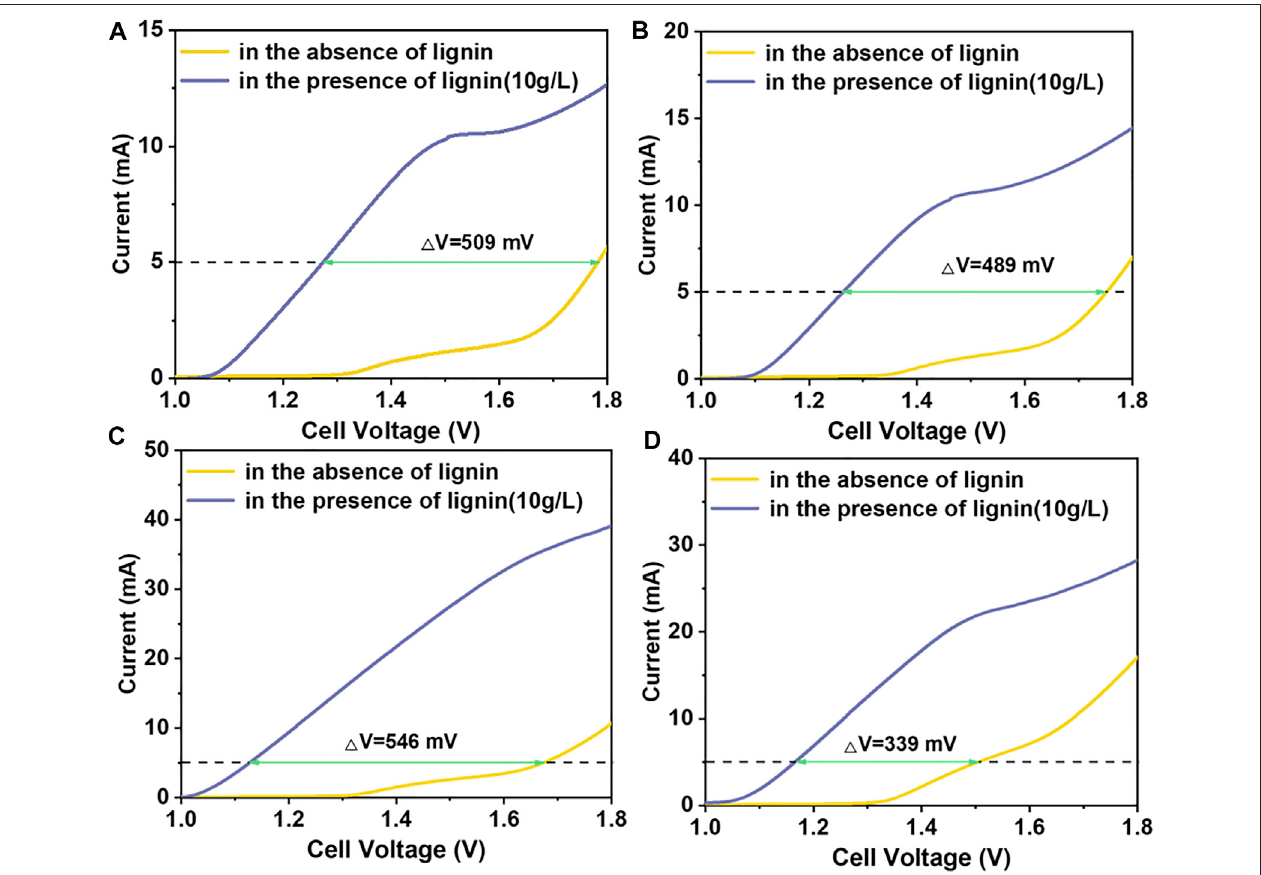
FIGURE3| ComparisonofLAWEandAWEatdifferenttemperatures:LSVcurvesof (A) 30 ° C, (B) 40 ° C, (C) 60 ° Cand (D) 90 ° C,withascanrateof5 mV/s.Solution: 1 mol/L NaOH.